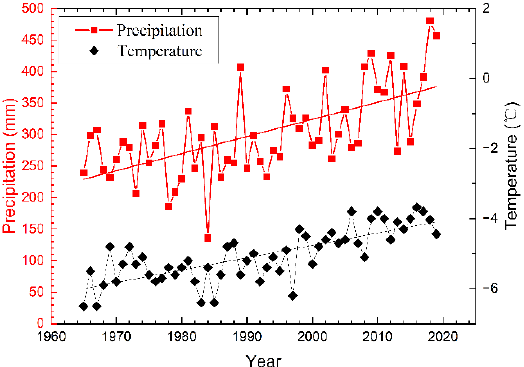
Figure 11. The mean annual air temperature and annual precipitation at Wudaoliang meteorological station.